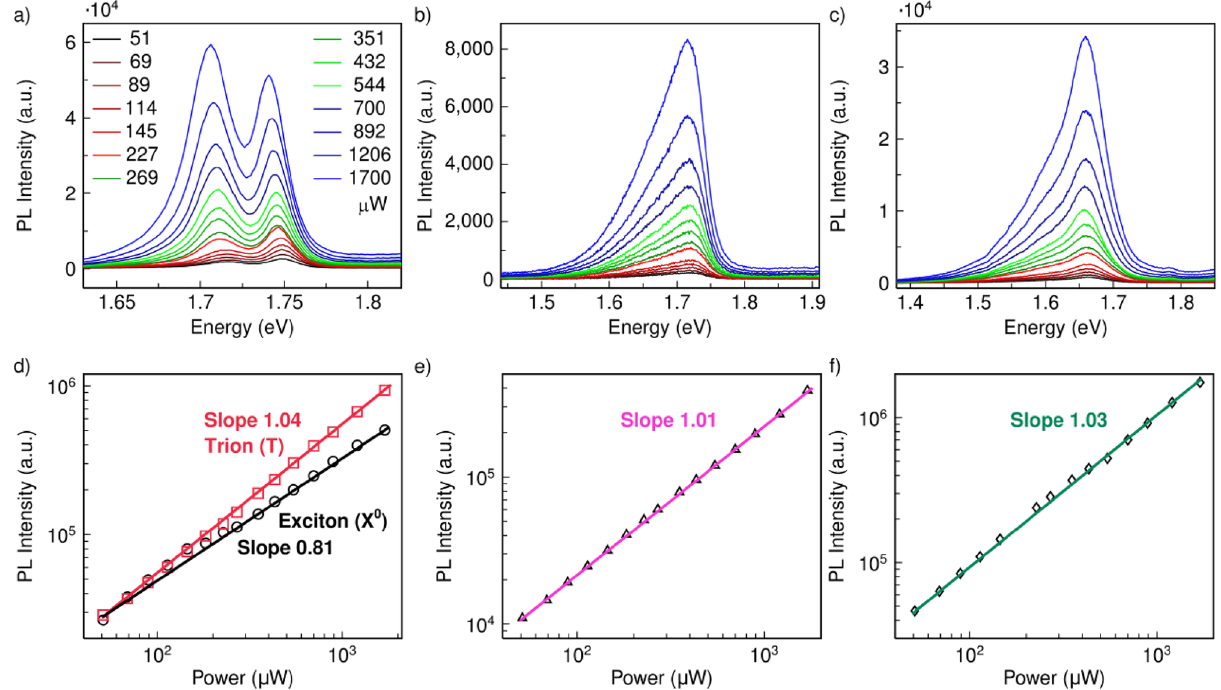
Figure 3. Investigations of the power-dependent PL spectra in different configurations. ( a ) Power-dependent PL spectra of WSe 2 /Nanocavity. ( b ) WSe 2 /Au Film. ( c ) WSe 2 /Sapphire. The excitation laser has energy of 1.96 eV. ( d – f ) Integrated PL intensity of WSe 2 /Nanocavity with left peak from 1.65 to 1.73 eV and right peak integrated from 1.73 to 1.76 eV ( d ), WSe 2 /Au Film with peak integrated from 1.55 to 1.77 eV ( e ), and WSe 2 / Sapphire with peak integrated from 1.46 to 1.76 eV ( f ), as a function of laser